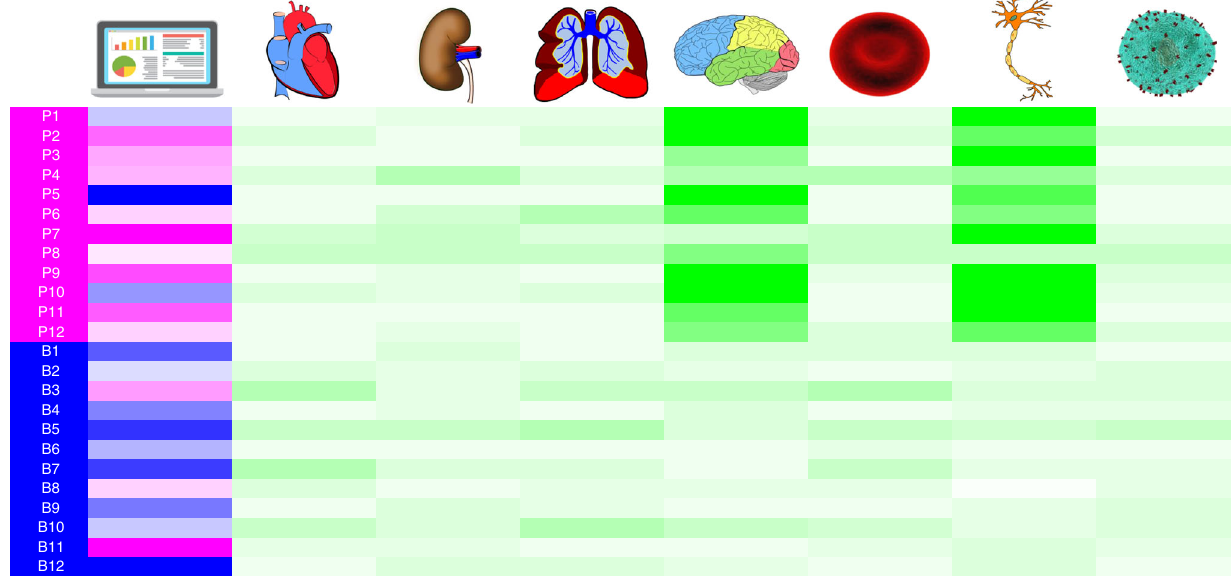
Fig. 1 Rationale for use of tissue and cell-speci fi c gene expression for prioritisation of variants associated with a brain disease phenotype. Pathogenic variants are coloured magenta and benign variants are coloured blue ( fi rst column). The second column shows in silico predictions of variant pathogenicity, where increasing magenta intensity indicates stronger probability of pathogenicity and increasing blue intensity indicates stronger probability of being benign. The remaining columns in order represent heart tissue, kidney tissue, lung tissue, brain tissue, red blood cells, neurons and T cells. The green colour scale represents gene expression, where increasing colour intensity indicates higher expression